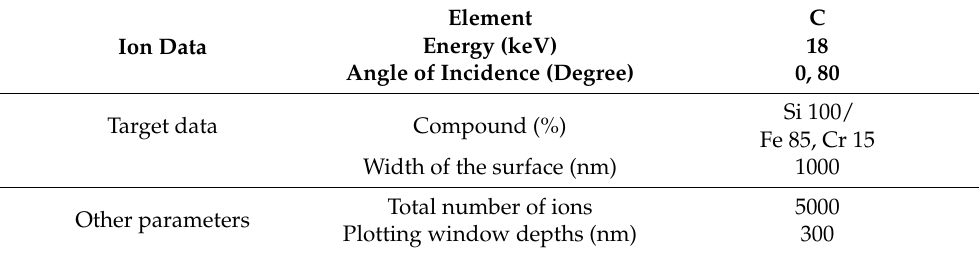
Table 3. Calculation conditions of